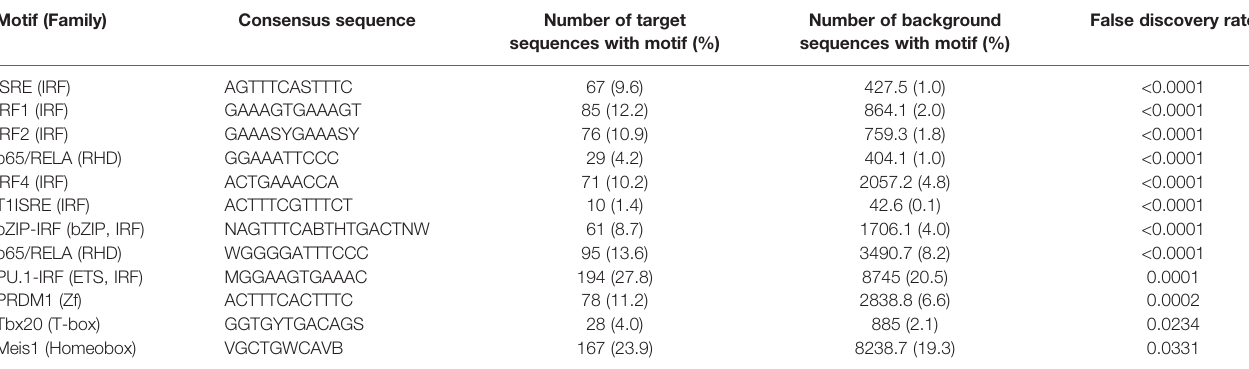
TABLE 2 | Transcription factor binding sites that were enriched in promoters of highly up-regulated genes (target sequences) in comparison with all genes (background sequences) in human iris pigment epithelial cells 24 hours following infection with ZIKV. Motif (Family) Consensus sequence Number of target Number of background sequences with motif (%) sequences with motif